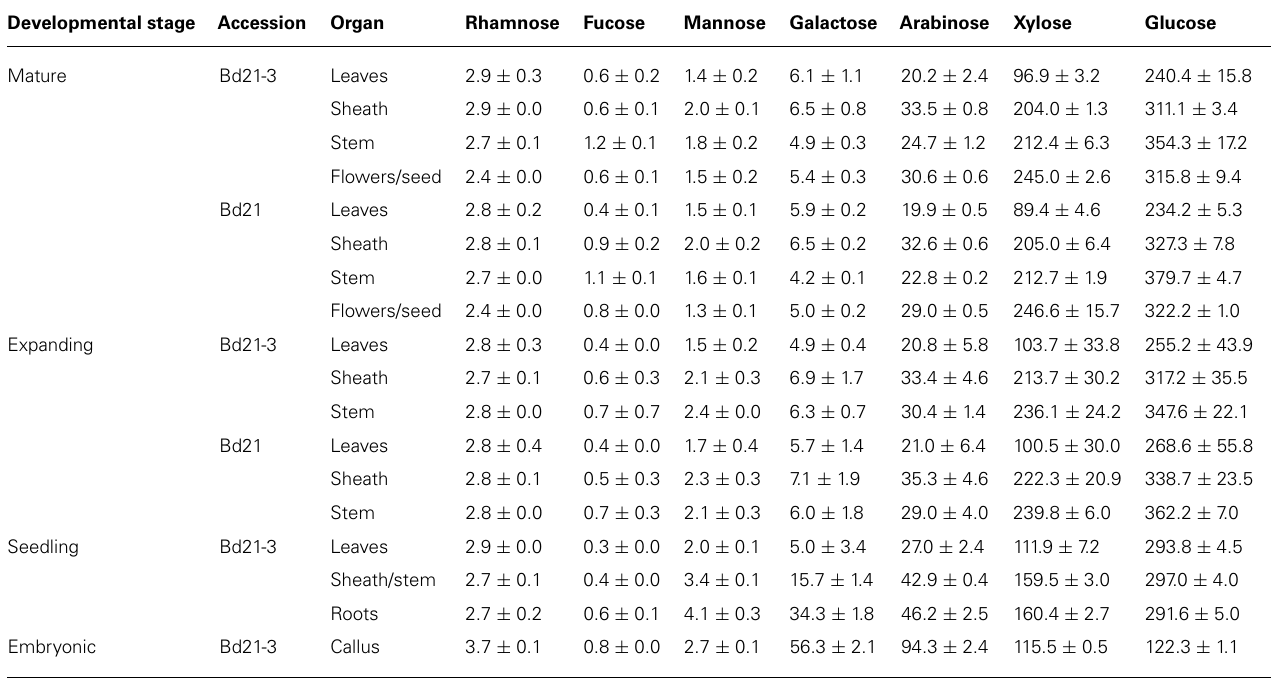
Table 3 | Neutral sugar content of Brachypodium cell walls*. Developmental stage Accession Organ Rhamnose Fucose Mannose Galactose Arabinose Xylose